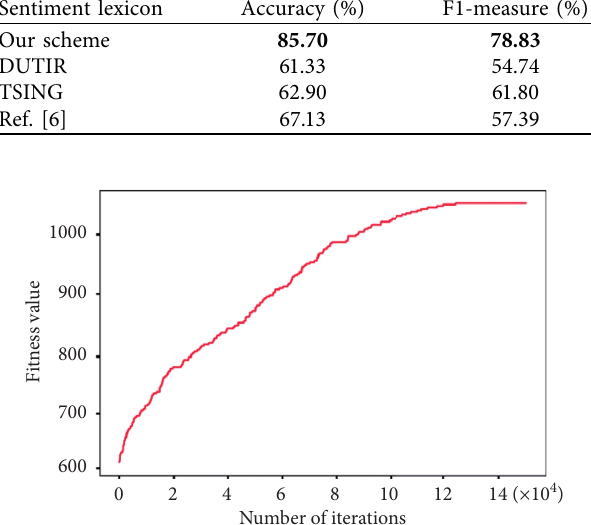
Figure 4: The convergence process of Algorithm 1. Algorithm 1 is converged after 128,000 iterations and totally updates 256,000 individuals.